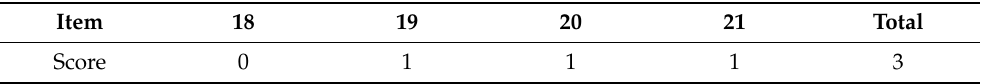
Table 4. Anna’s scores on the four items of the subcomponent Family/Marital (FM). Item